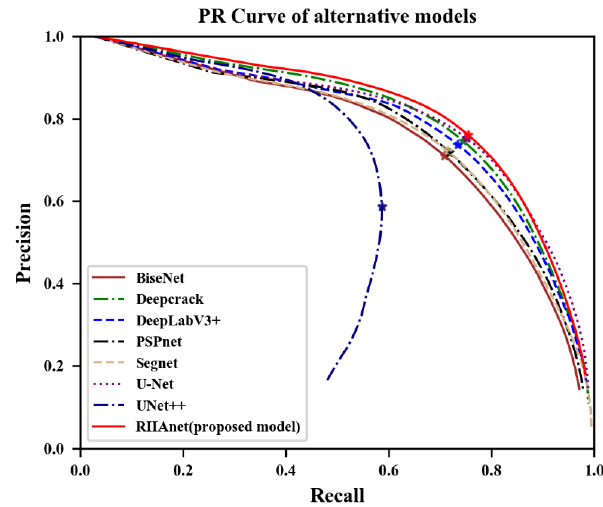
Figure 13. Precision-recall curves for different models on the test set .